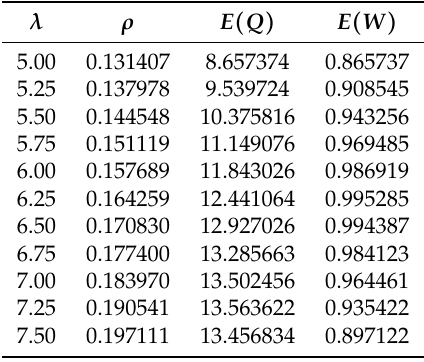
Table 2. Main server’s service rate vs. expected queue length and expected waiting time for the